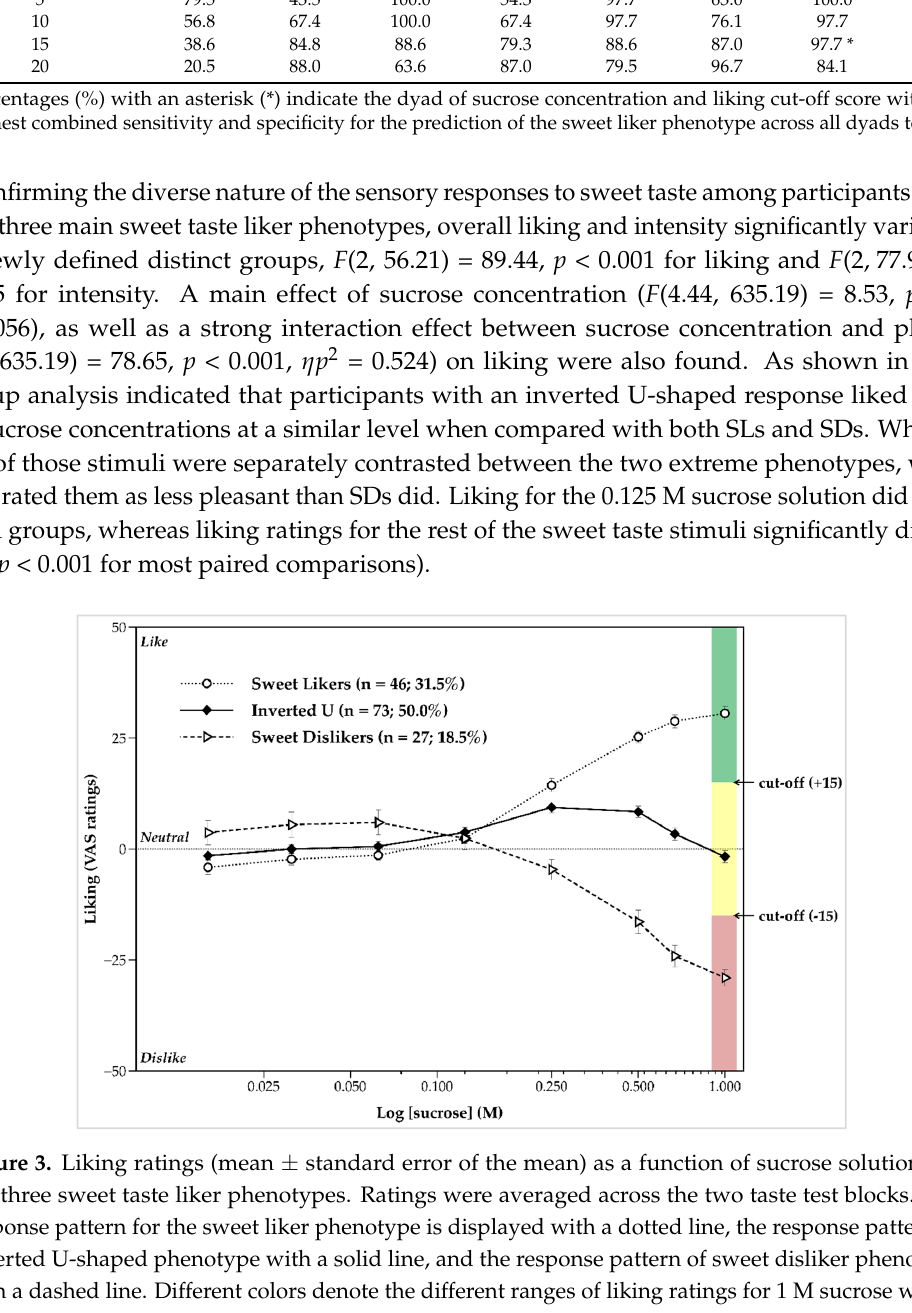
Figure 4. Intensity ratings (mean ± standard error of the mean) as a function of sucrose solutions by the three sweet taste liker phenotypes. Ratings are averaged across the two taste test blocks. The intensity curve of the sweet liker phenotype is displayed with a dotted line, the intensity curve of the inverted U-shaped phenotype with a solid line, and the intensity curve of the sweet disliker phenotype with a dashed line.